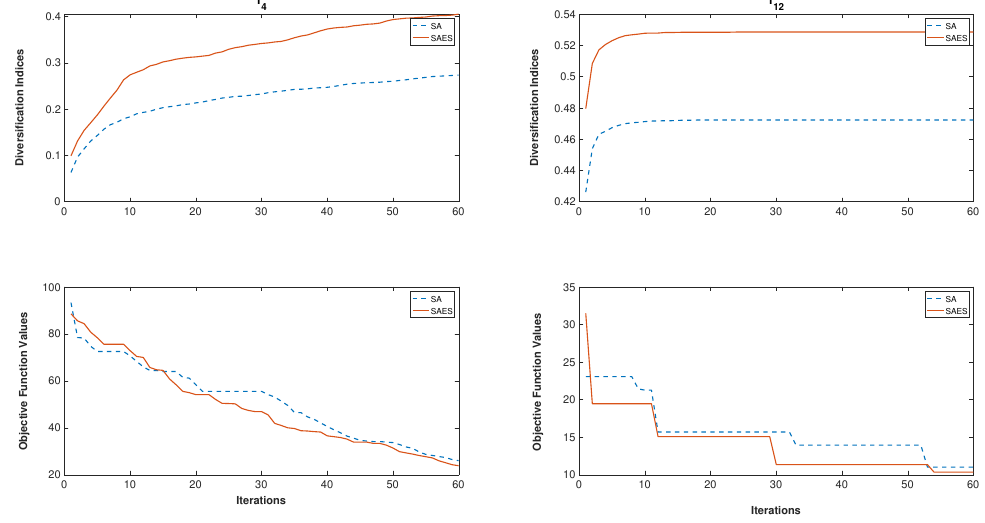
Figure 7. Examples of the SA and SAES diversification performance using classical test functions.